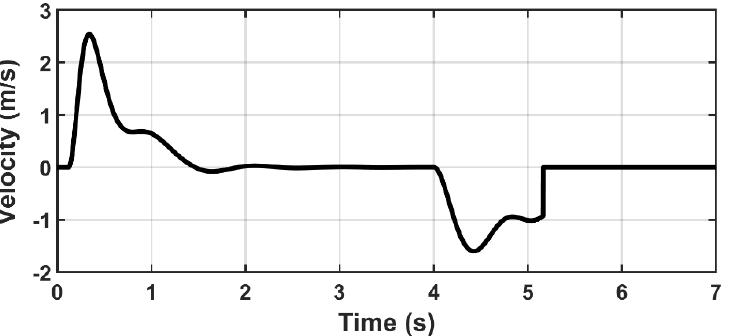
Figure 5. Dynamic responses of the loading arm velocity during lifting and lowering a